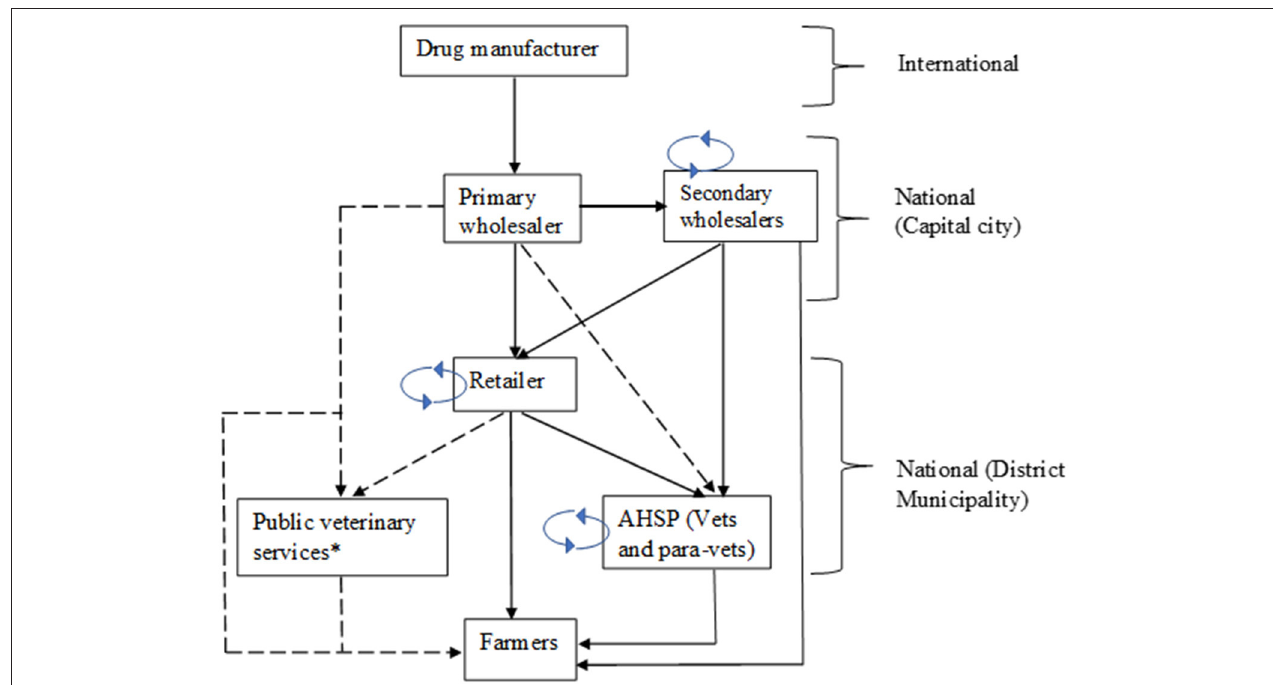
FIGURE 1 | Veterinary drug and vaccine supply chains in Uganda. The flux distribution was determined based on perception of stakeholders (Full line = high flux distribution channel; Dotted line = low flux distribution channel); *Public veterinary services procure mainly vaccines for endemic diseases and acaricides; Continuous loop indicated the back-and-forth sales among same stakeholders. The determination of the flux was based on the knowledge and perception of